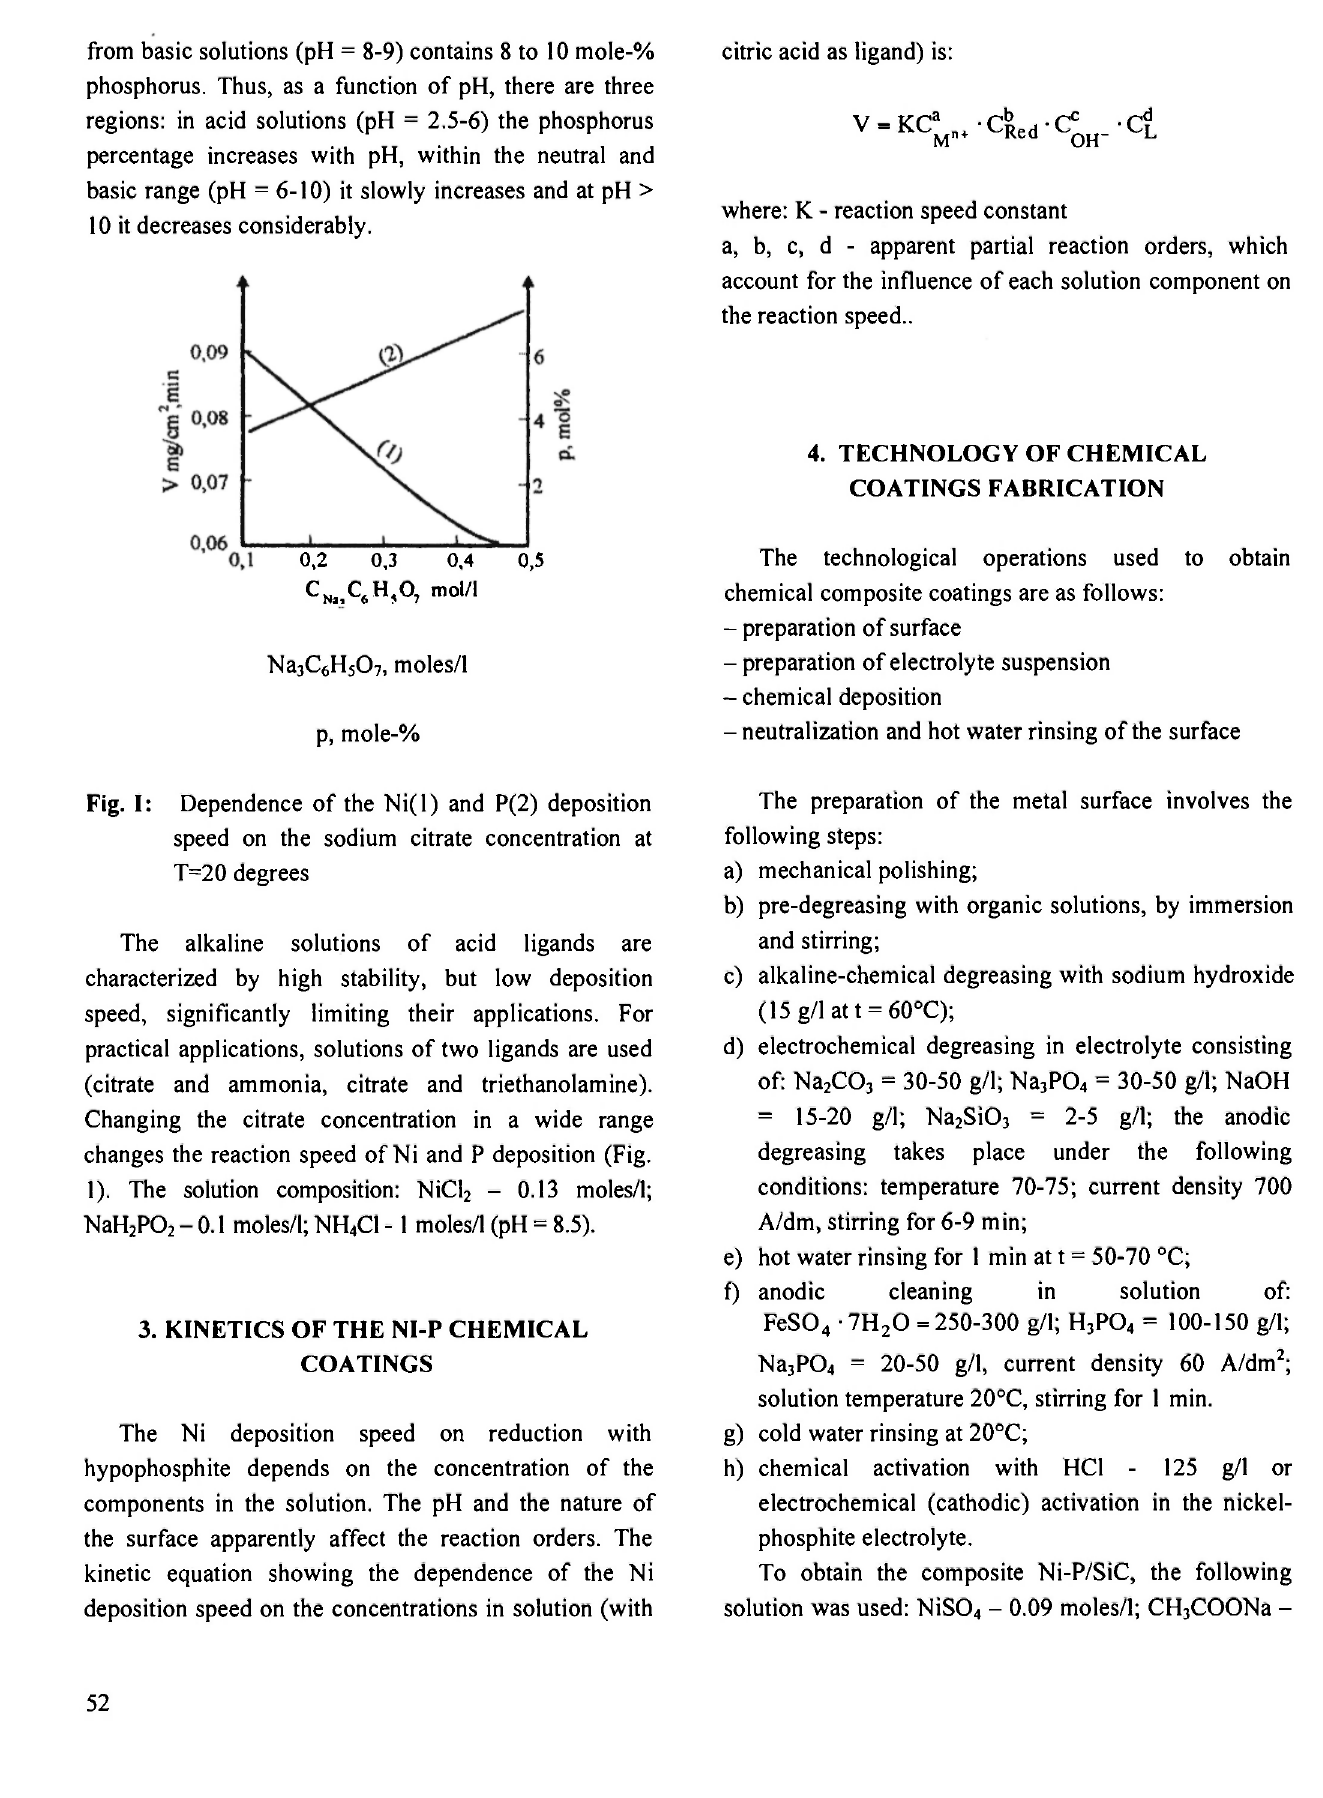
Dependence of the Ni(l) and P(2) deposition speed on the sodium citrate concentration at T=20 degrees The characterized by high stability, but low deposition speed, significantly limiting their